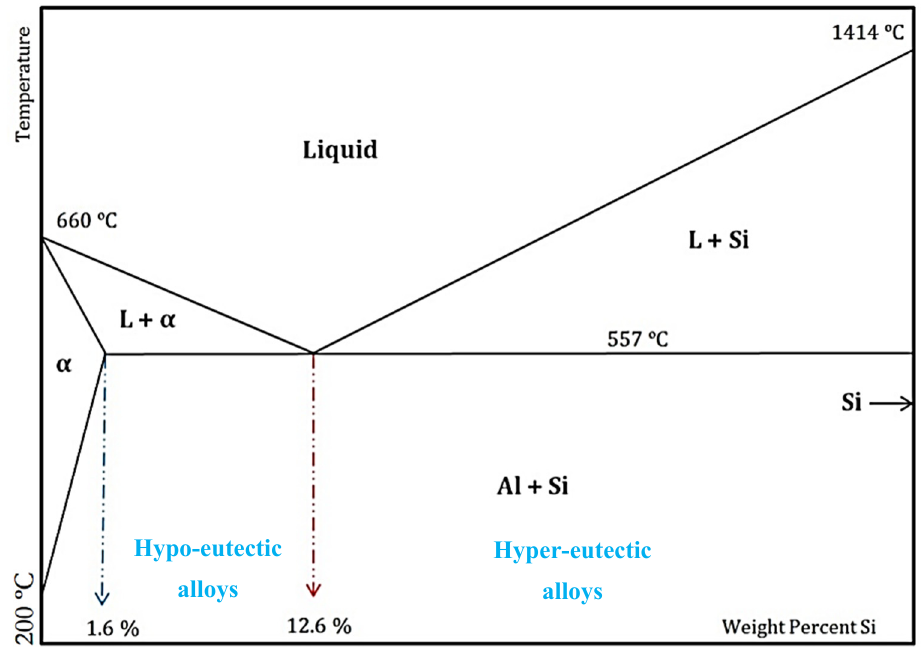
Figure 1. The schematic phase diagram of Al–Si [4].